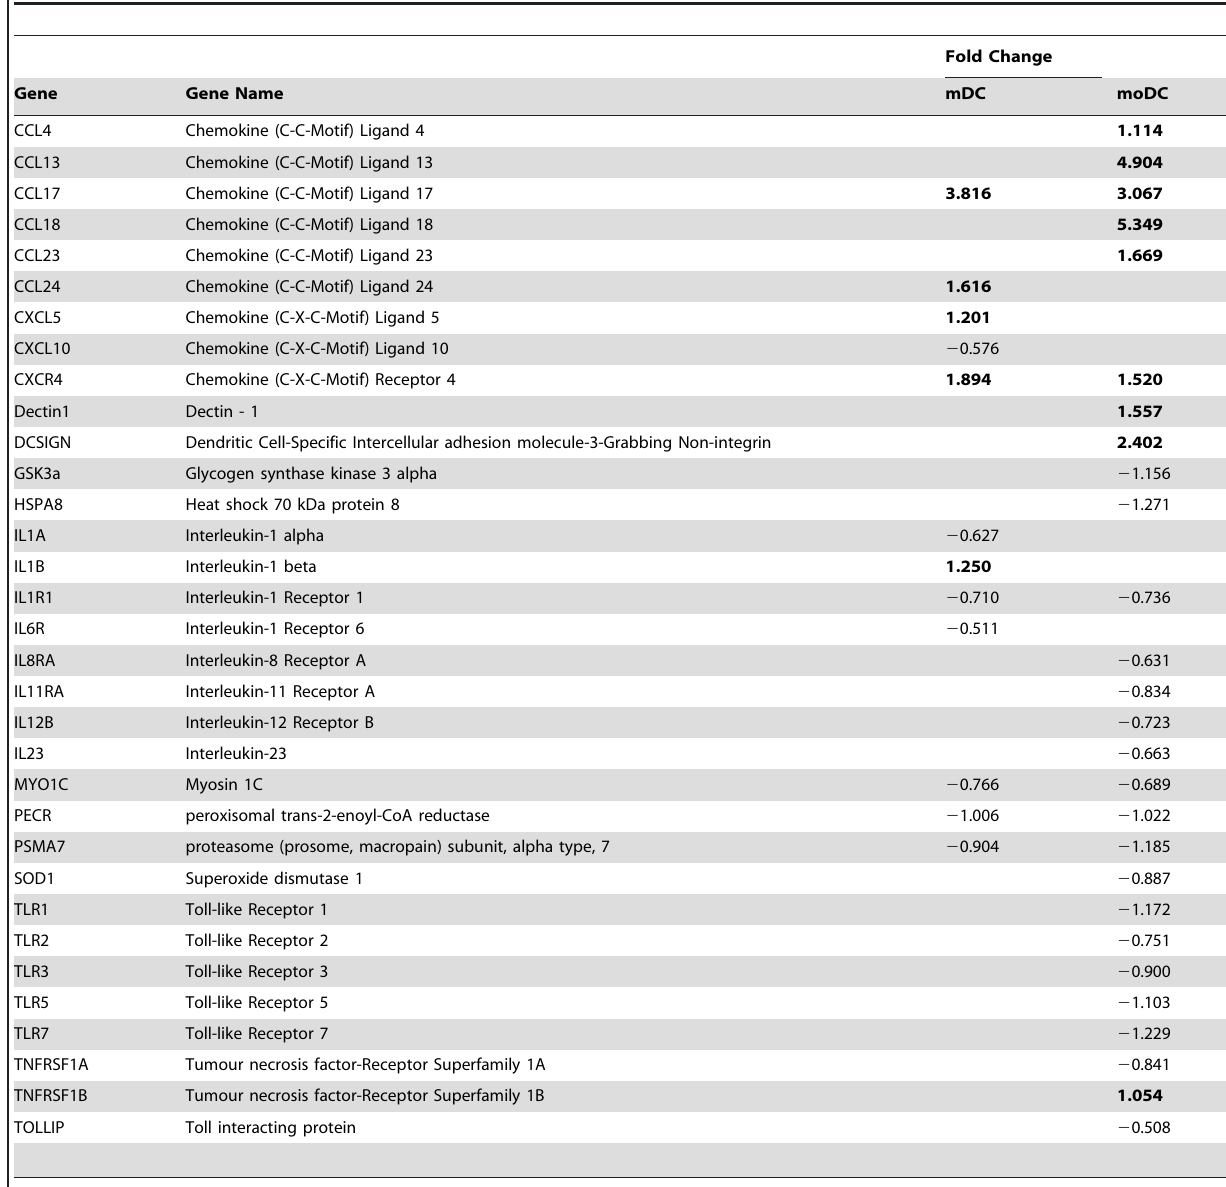
Table 5. Gene Expression in A549 epithelial cell layer and donor myeloid dendritic cells or monocyte-derived dendritic cells without the addition of A. fumigatus germ tubes (after 6 hours